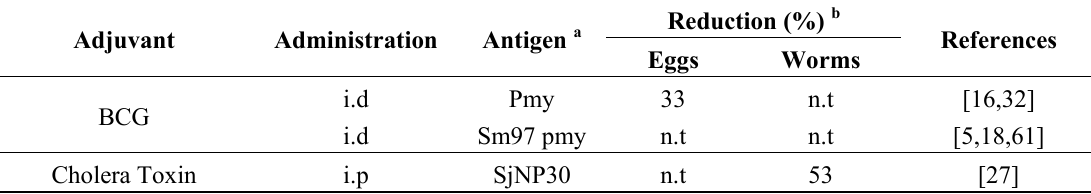
Table 7. Microbial-adjuvanted Schistosoma vaccine candidates classified as a function of the adjuvant.